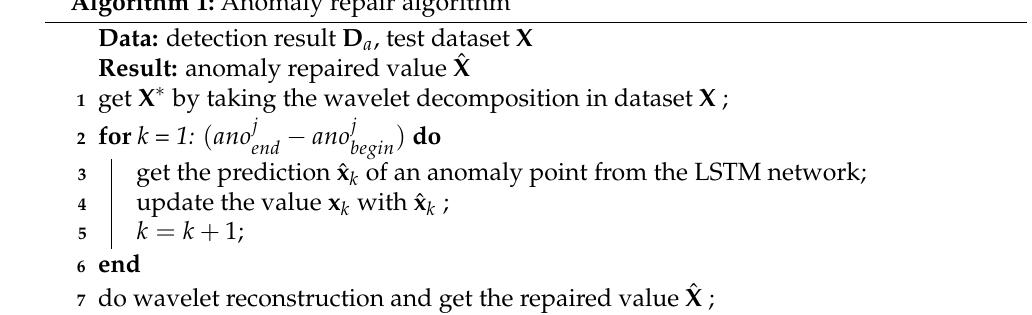
Algorithm 1: Anomaly repair algorithm Data: detection result D a , test dataset X